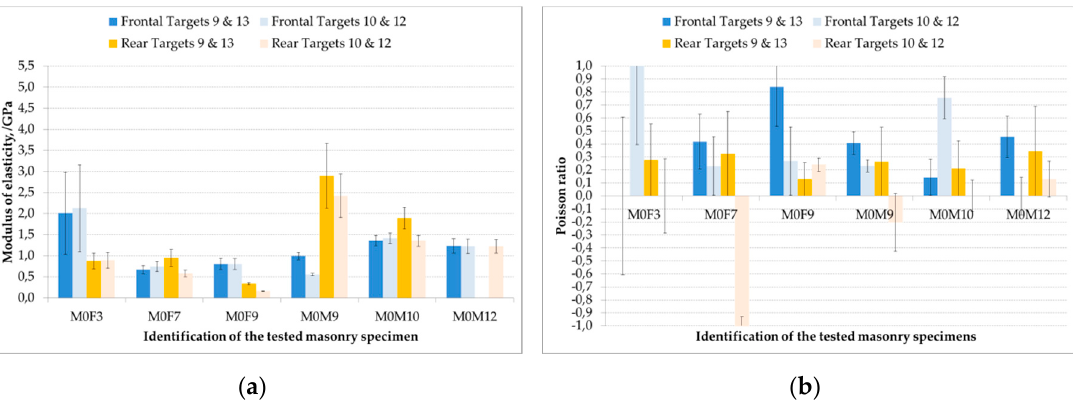
Figure 14. Estimates and standard uncertainties obtained from the optical measurement system for ( a ) the modulus of elasticity; ( b ) and the Poisson ratio.